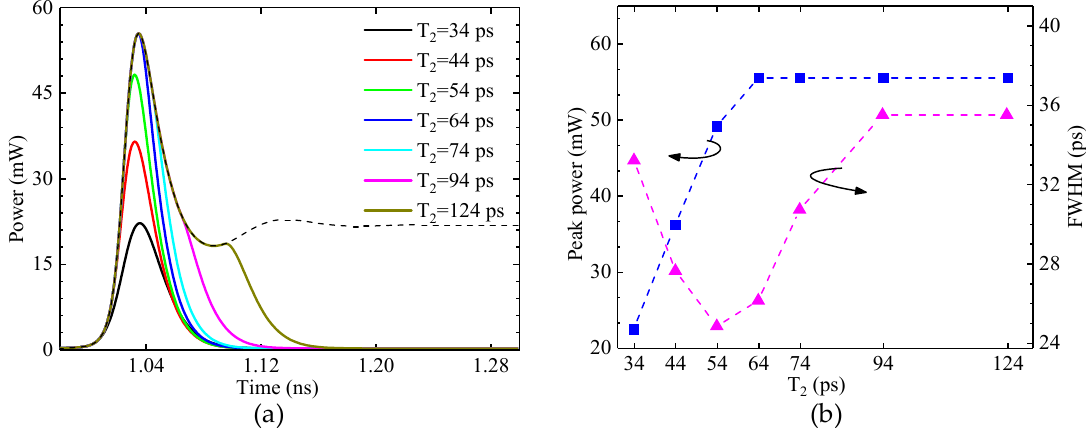
Figure 4. Simulation results of output pulses at different